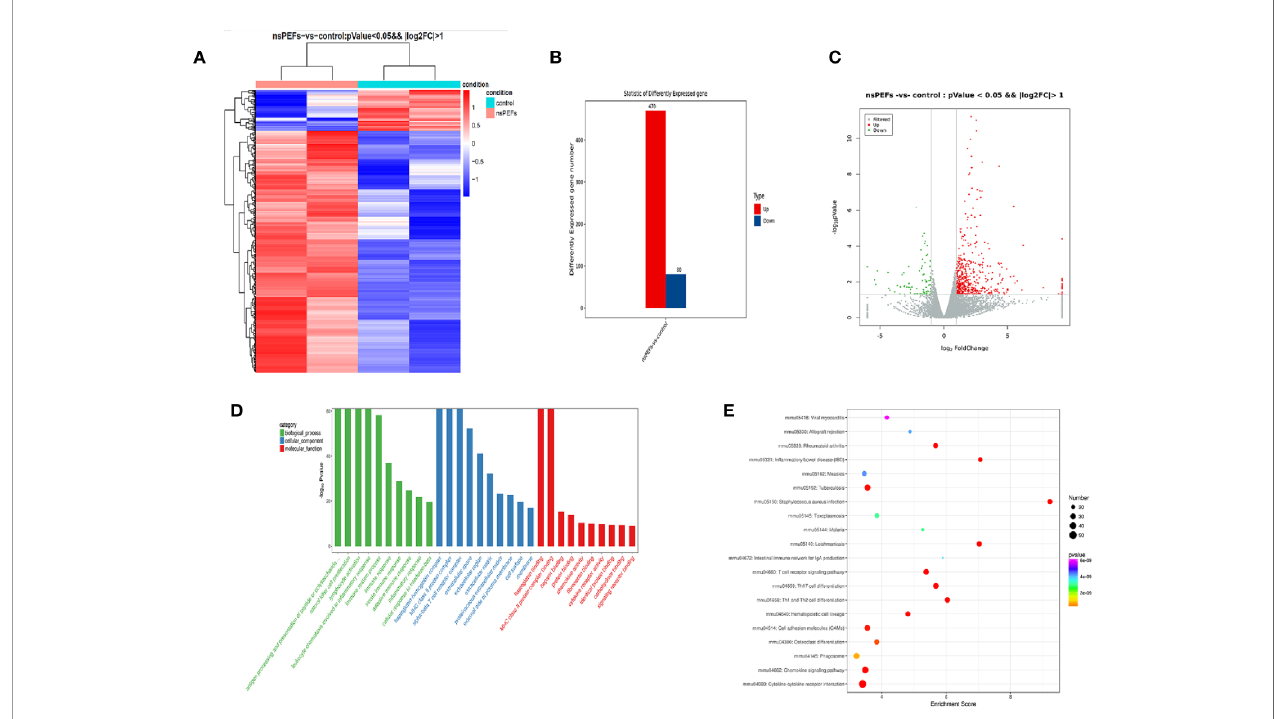
FIGURE 4 | (A) Hierarchical clustering of differentially expressed mRNAs. Hierarchical clustering was performed using differentially expressed mRNAs between the nsPEFs-treated group and the control group. The gene expression values (log2-transformed intensities) are scaled and depicted in color code format (upregulated: red, downregulated: blue). (B) Bar chart of differentially expressed mRNAs between the nsPEFs-treated group and the control group (upregulated: red, downregulated: blue). (C) The expression pro fi les of the identi fi ed differentially expressed genes (DEGs). Red and green points represent the signi fi cant DEGs with p < 0.05 and log2(fold change) >1, and grey points show those without signi fi cance, respectively. Fold change refers to the values of FPKM change. (D) GO classi fi cation of DEGs. GO terms are summarized in three main categories: cellular component, molecular function, and biological process. (E) Top 20 pathways of KEGG functional enrichment among DEGs. The color of nodes changes from purple - blue - green - red, and the smaller the enrichment p-value, the greater the signi fi cance. The point size denotes the DEG